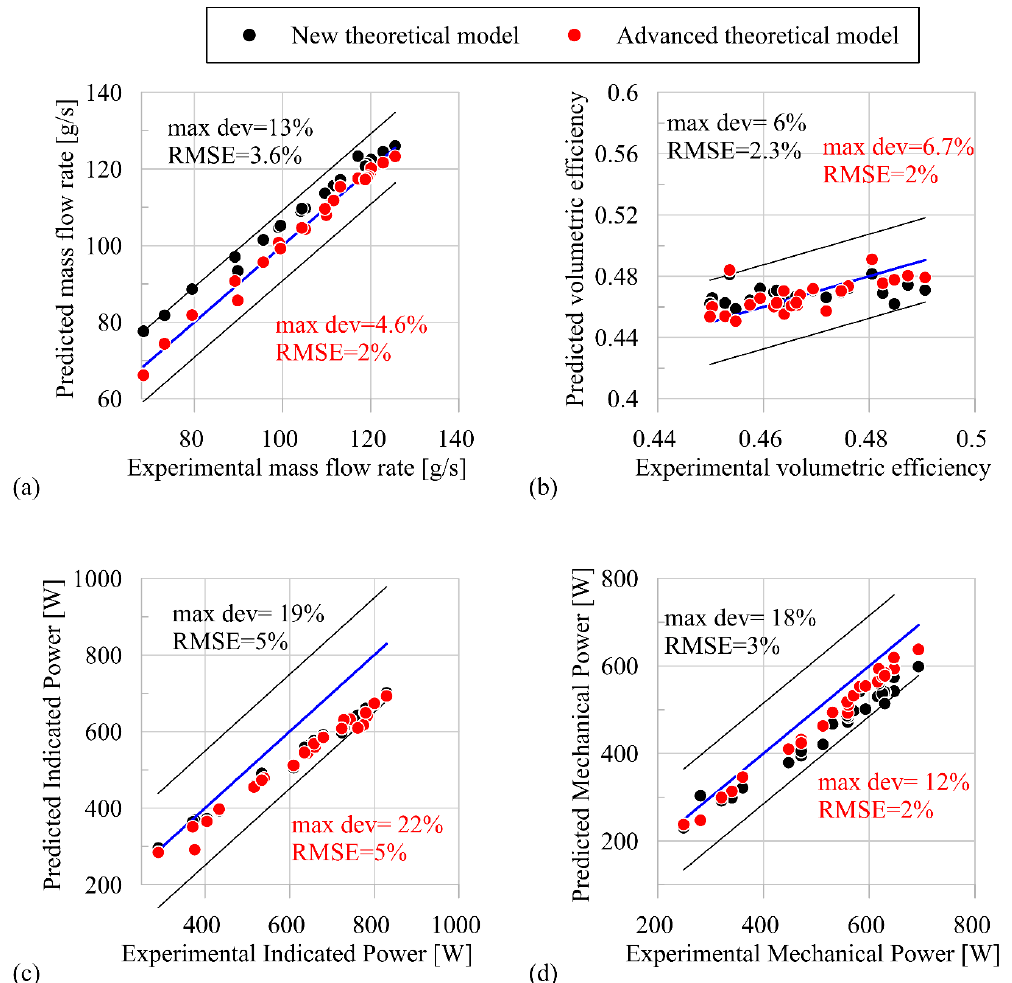
Figure 5. Comparison between experimental data and new theoretical and advanced theoretical predictions about ṁ WF ( a ) , η vol ( b ), P ind ( c ), and P mech ( d ).